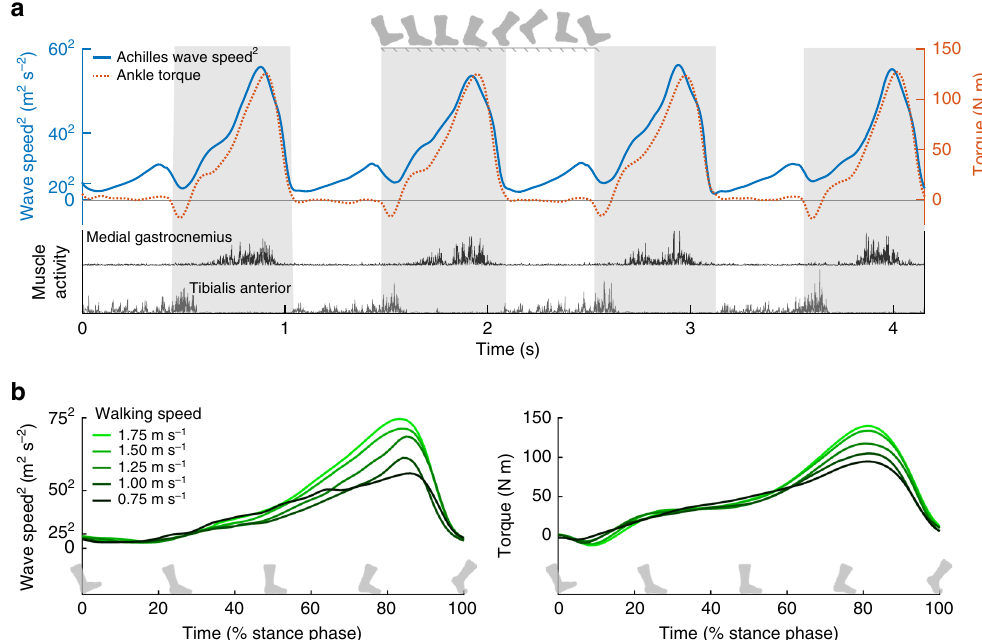
Fig. 4 In vivo gait experiment. a Achilles tendon wave speed, ankle plantar fl exion torque, and medical gastrocnemius and tibialis anterior muscle activity over 4 consecutive strides of treadmill walking at 1.5 m s − 1 . The primary peak in wave speed corresponds to push-off in late stance (stance indicated by shaded regions), when the gastrocnemius is active and ankle torque is high. However, a secondary peak in wave speed is seen in late swing and likely re fl ects passive tendon stretch due to antagonistic tibialis anterior activity. b Stance phase plots, ensemble averaged over multiple gait cycles for a representative subject show speed-related modulation of both Achilles tendon wave speed and ankle plantar fl exion